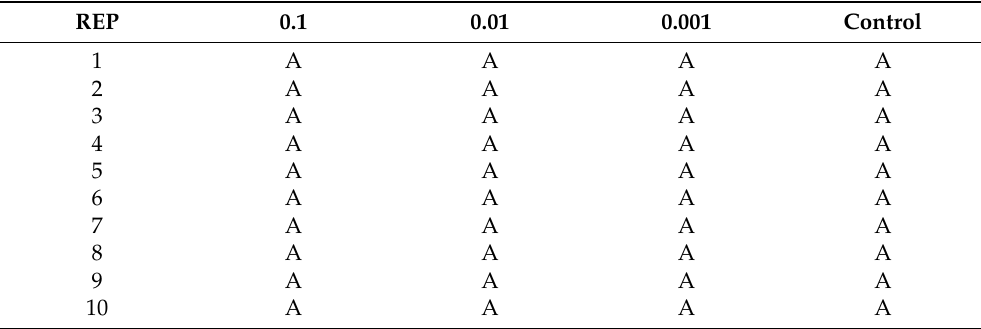
Table 1. Glyphosate w/ C. circumpicta larvae. Dilutions mixed at 1 mg/1 mL stock solution. Ten repetitions with control (distilled water) at determined concentrations. 48 h exposure. D = Dead; A = Active; M = movement with stimulation. No established LD 50 . REP 0.1 0.01